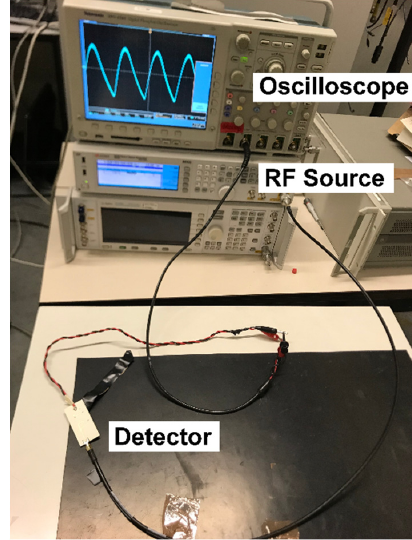
Figure 16. Measurement setup for the investigation of the bandwidth of the detectors. An RF source is used to set the two-tone signal and the oscilloscope is needed to acquire the output voltage waveform.